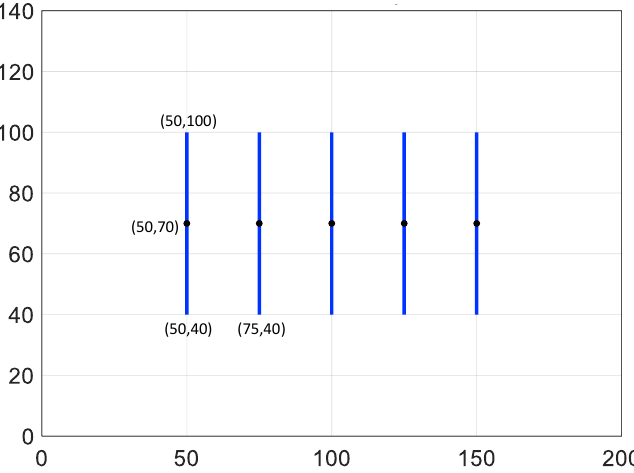
Planar Fracture Figure 17. Scheme for the comparison with the in-house simulator (simulation VE2).